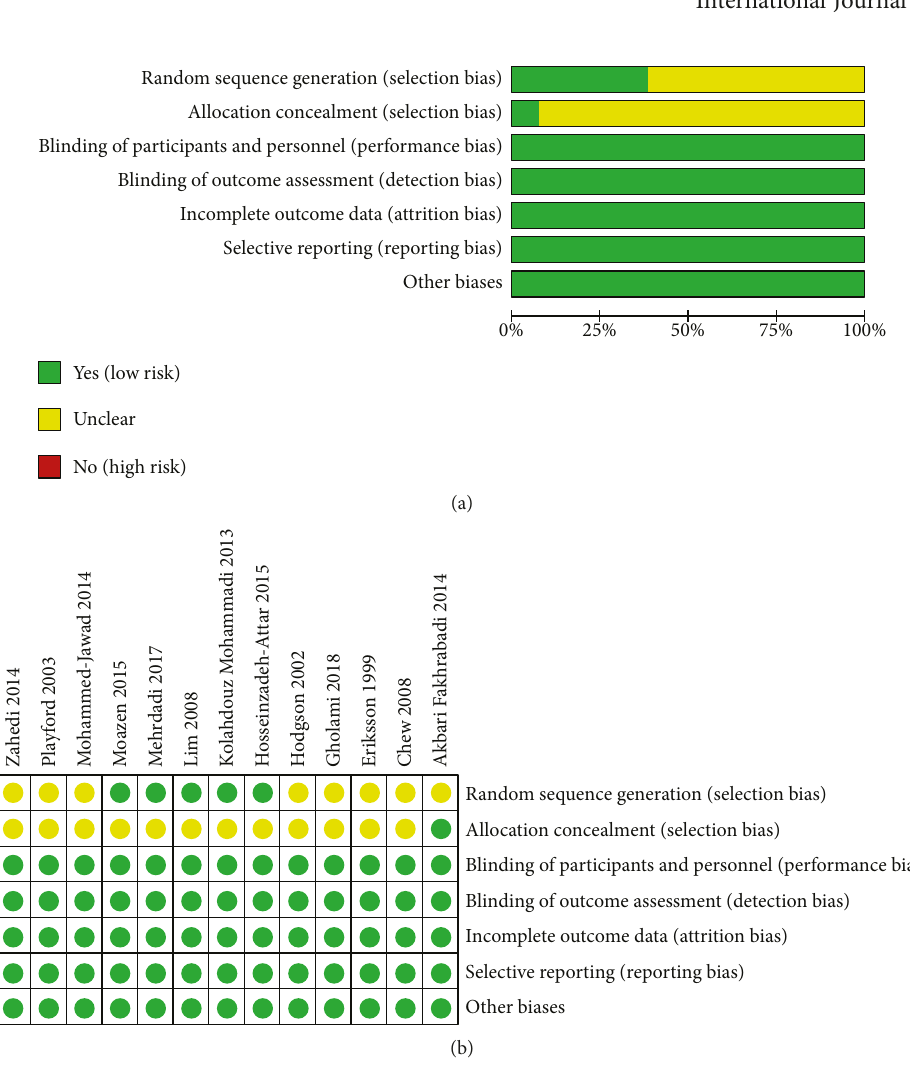
Figure 2: (a, b) The risk of